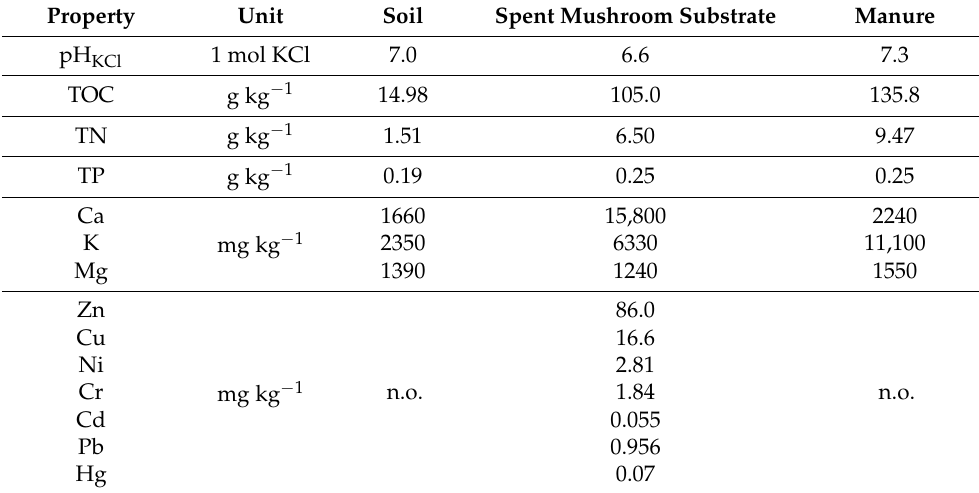
Table 1. Properties of soil und